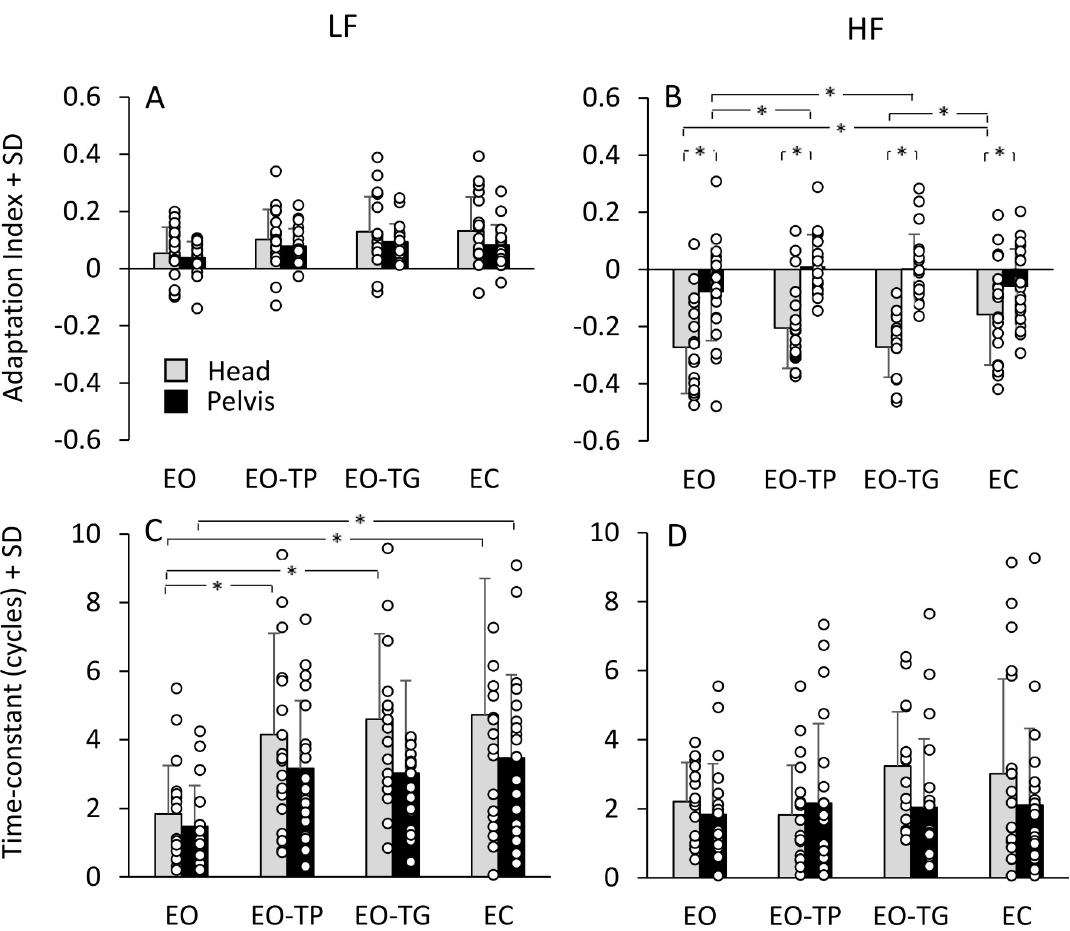
Fig 5. Parameters of the adaptation process. A and B: mean adaptation indices calculated for each visual condition under LF (A) and HF (B). Value of AI near zero indicate that the amount of adaptation is modest. This occurs when the value of the PP displacements at end of the translation cycles of the platform are similar to the PP displacement at the beginning of the platform translation. Positive values of AI indicate that the data showed an increasing exponential trend as a function of the subsequent translation cycles, while negative AI values were associated to a decreasing exponential trend. C and D: mean time-constants calculated by fitting an exponential curve to the PP displacement data over cycles for LF (C) and HF (D). Grey bars refer to head, black bars refer to pelvis. The white dots superimposed to the bars are the values of the AI and of the time-constant of each subject. Asterisks indicate significant difference (p < 0.05).